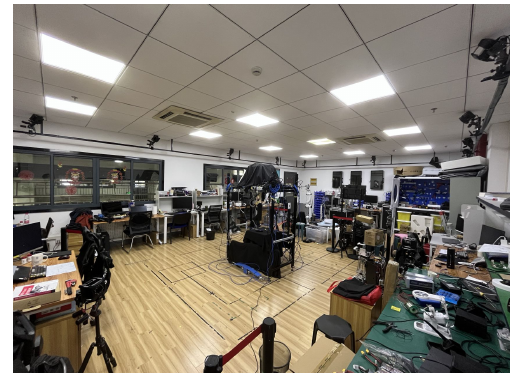
Figure 3. The scene of the room environment.